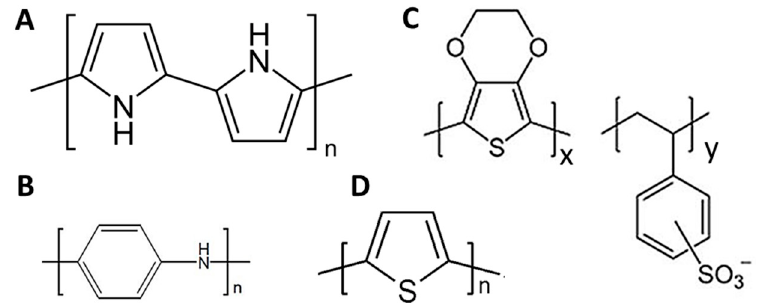
Figure 1. ( A ). Poplypyrrole, ( B ). Polyaniline, ( C ). Poly(3,4-ethylenedioxythiophene) polystyrene sulfonate, ( D ). Polythiophene.